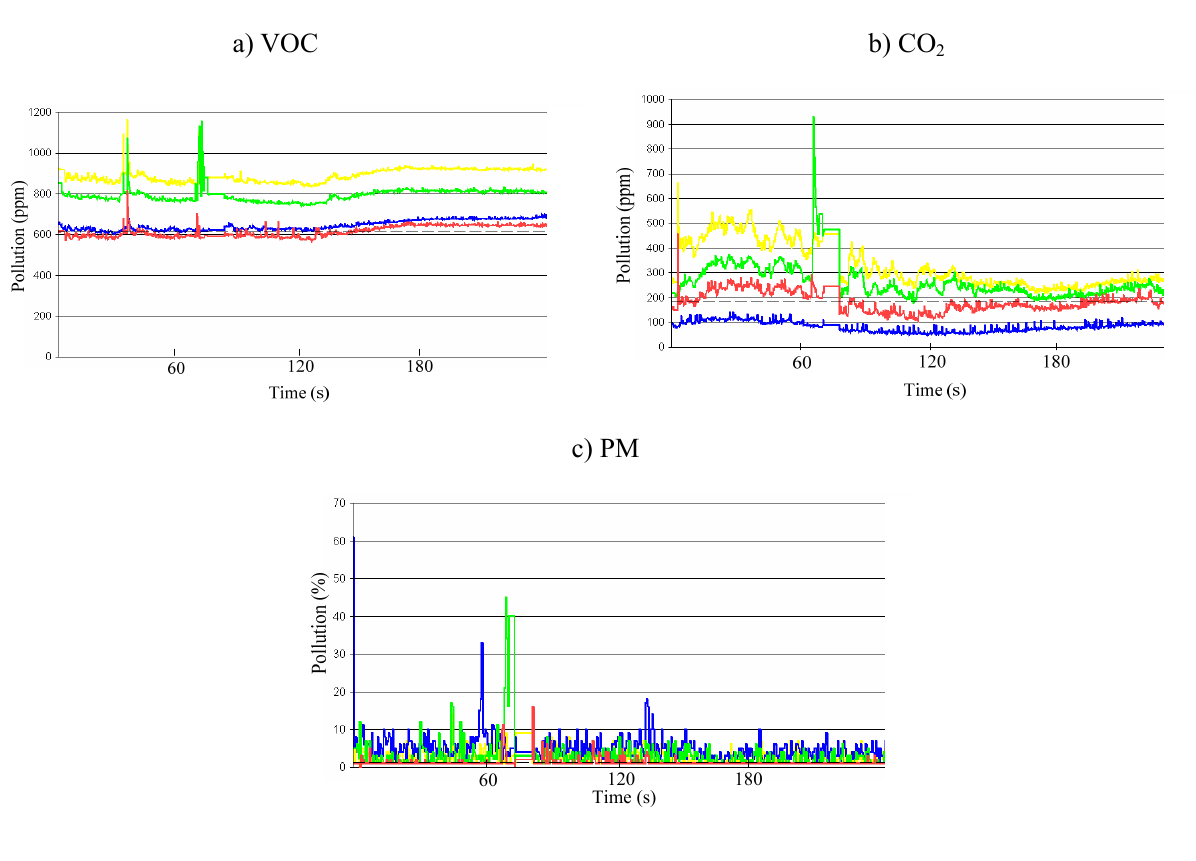
Figure 2. Sensing values with multiple nodes.